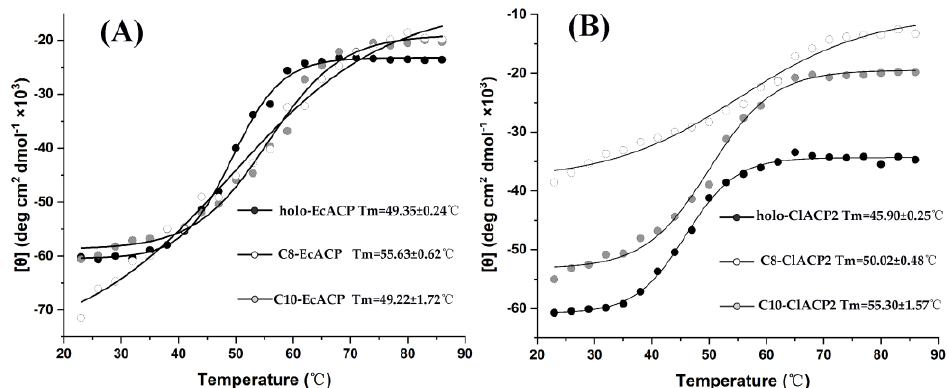
Figure 4. Melting temperature curves of ACP. ( A ) The thermal-induced melting temperature curves of holo-, C8- and C10-EcACP. ( B ) The thermal-induced melting temperature curves of holo-, C8- and C10-ClACP2.